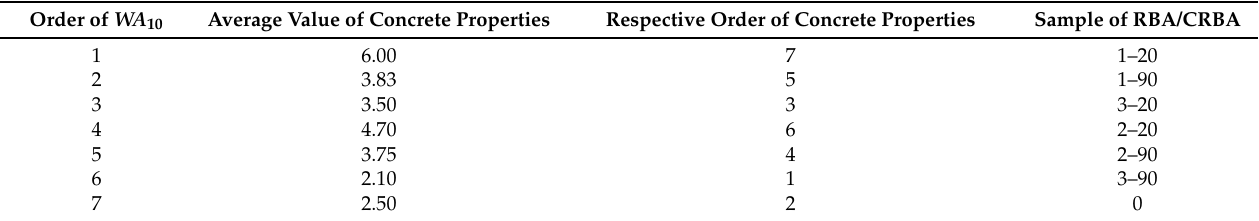
Table 6. The final ranking by the lowest WA 10 and respective treatment of RBA/mixture of